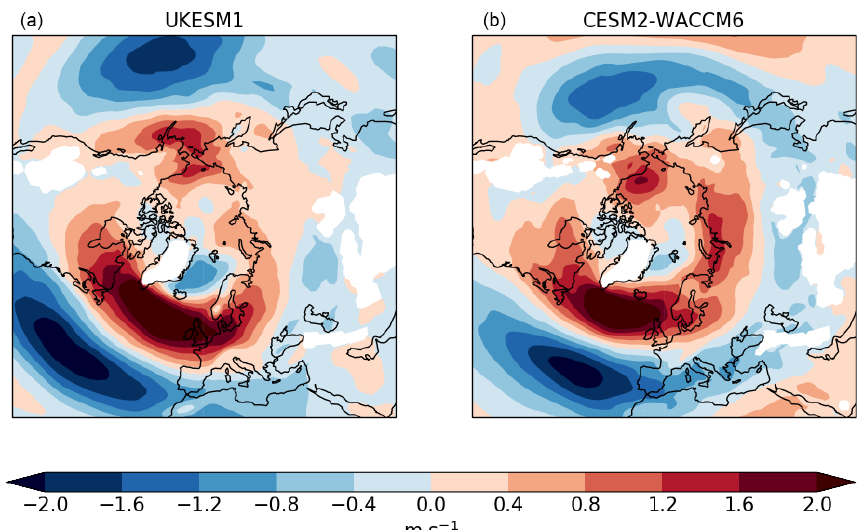
Figure 6. The distribution of the 2081–2100 mean December–February zonal wind speed perturbation due to SAI at 850hPa (ms − 1 ) for UKESM1 (a) and CESM2-WACCM6 (b) . Positive values represent a westerly perturbation and negative values an easterly perturbation; white areas indicate regions where the surface elevation is higher than the mean 850hPa pressure